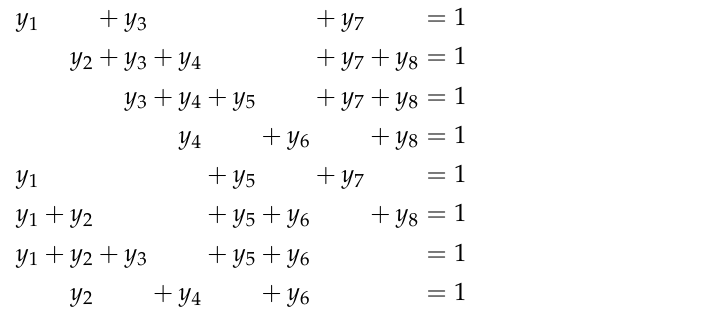
Figure 3. Checkerboard coloured region to be tiled with coloured